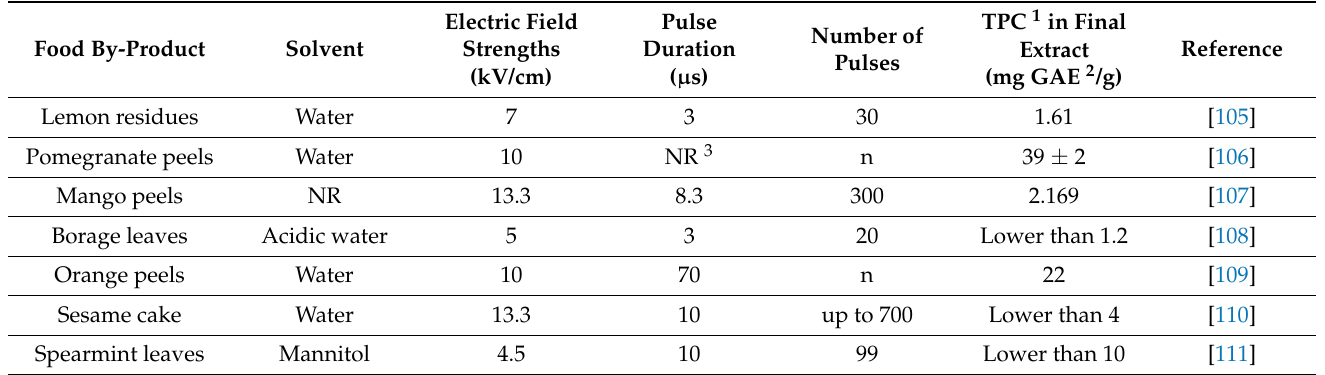
Table 4. Recovery of polyphenols from various food by-products using PFE